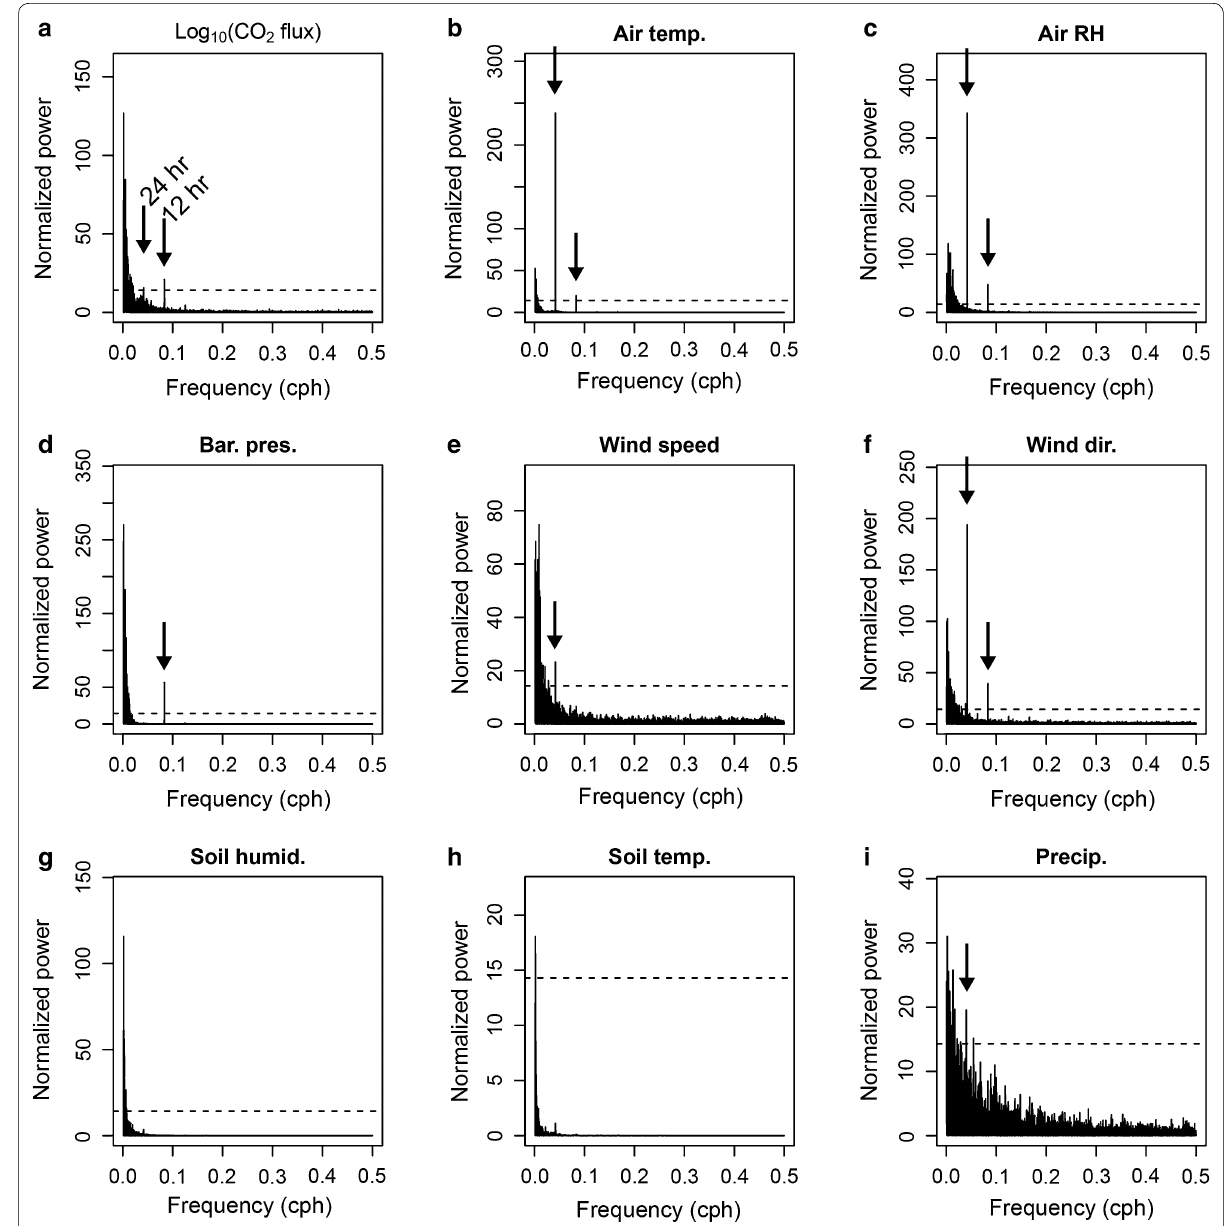
Fig. 7 Lomb–Scargle periodograms of a soil CO 2 flux, b air temperature, c air relative humidity, d barometric pressure, e wind speed, f wind direction, g soil humidity, h soil temperature, and i precipitation. The dotted line in each periodogram corresponds to the level where the probability equals 0.01. The periodogram from 0.001 cph (period 42 days) to 0.5 cph (2 h) is plotted. The arrows indicate significant diurnal and = semidiurnal